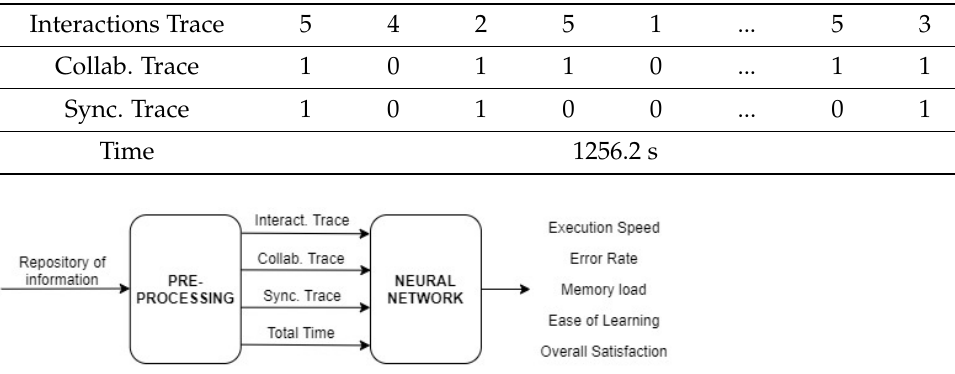
Figure 3. Diagram of the proposed